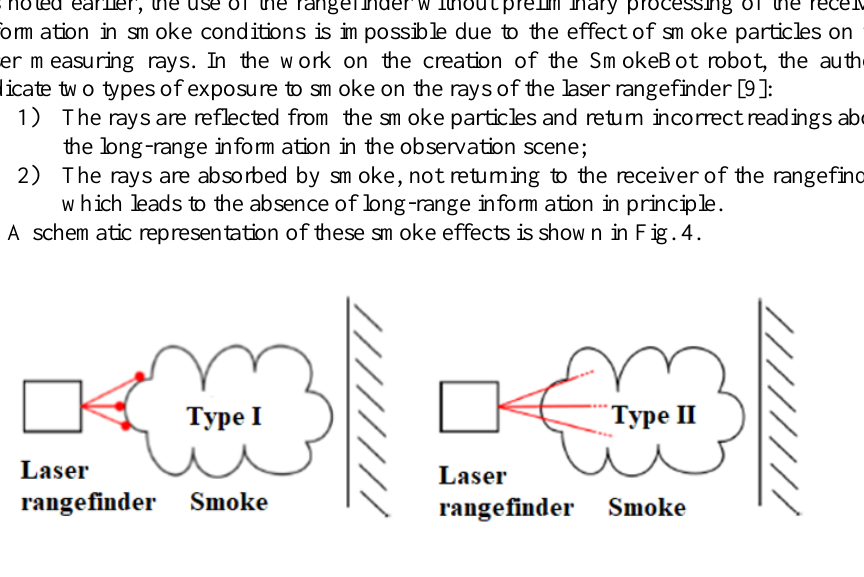
Fig. 4. The effect of smoke on the readings of the